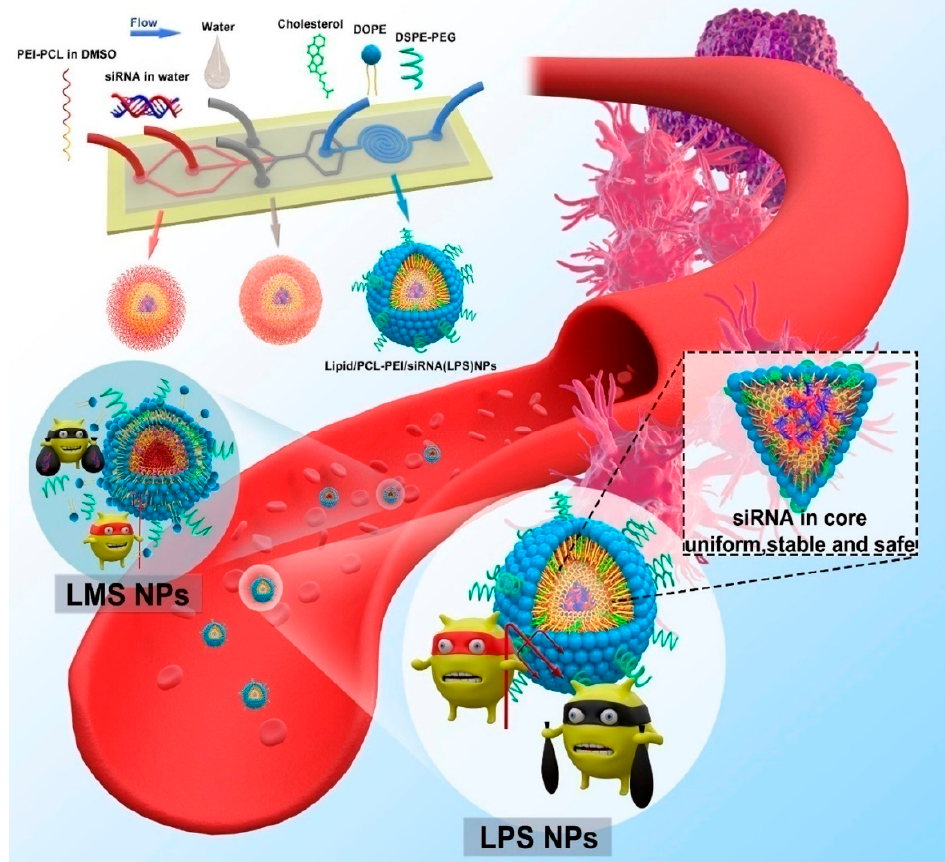
Figure 11. Synthesis of CSLPHNPs for delivery of siRNA with enhanced in vivo stability. The hybrid system synthesized by three-staged microfluidic technology with polyethyleneimine-polycaprolactone (PEI-PCL) in organic phase further coated over gene-loaded neutral lipid layer. Due to the lipid membrane coating, the core-shell contains reversed micelle via hydrophobic interaction, resulting in enhanced stability in vivo. Reprinted with permission from [136], Copyright © 2020, American Chemical Society.